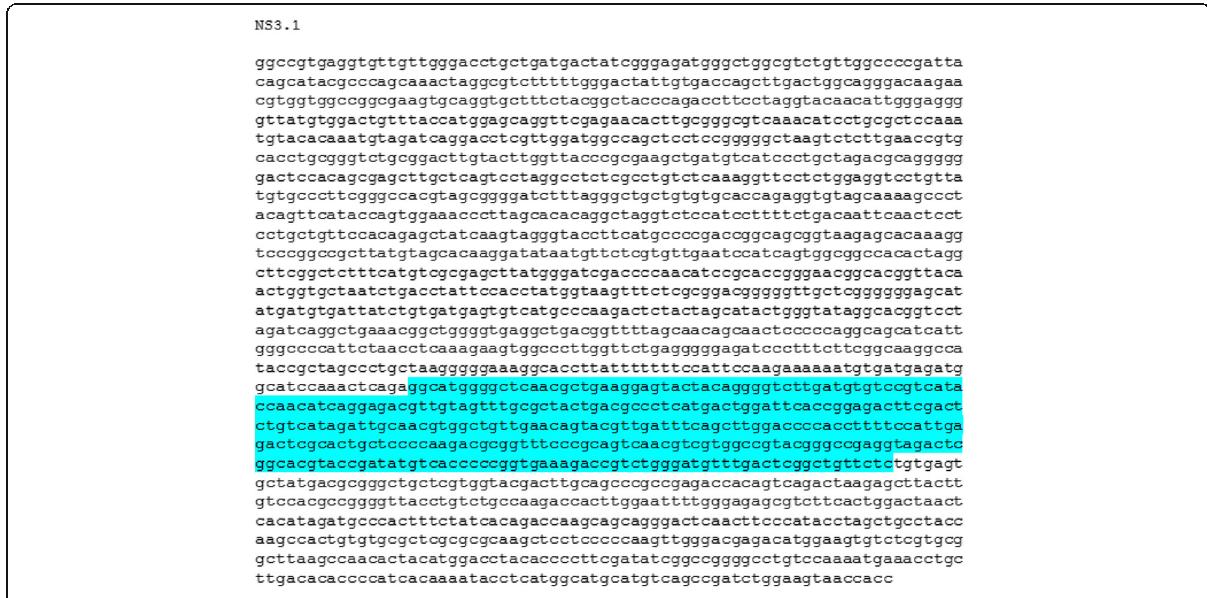
Fig. 1 Full gene sequence of NS3 gene indicating (highlighted) specific antigenic site NS3.1